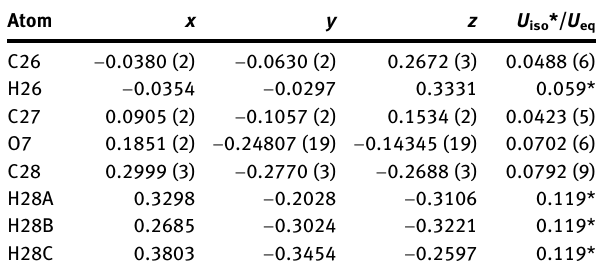
Table  : Fractional atomic coordinates and isotropic or equivalent isotropic displacement parameters (Å 